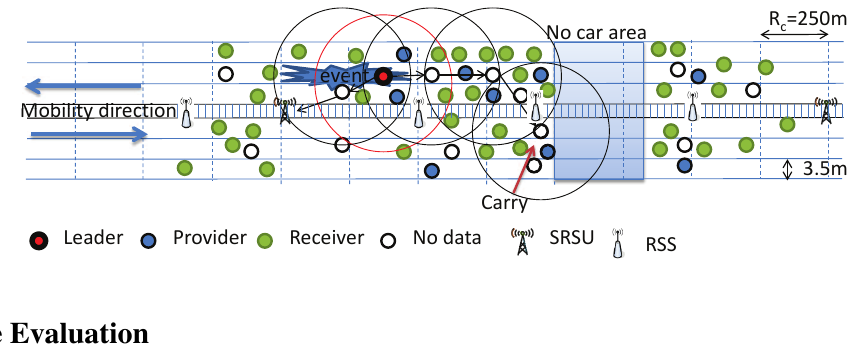
Figure 12. Selection of the next Leader when the network is